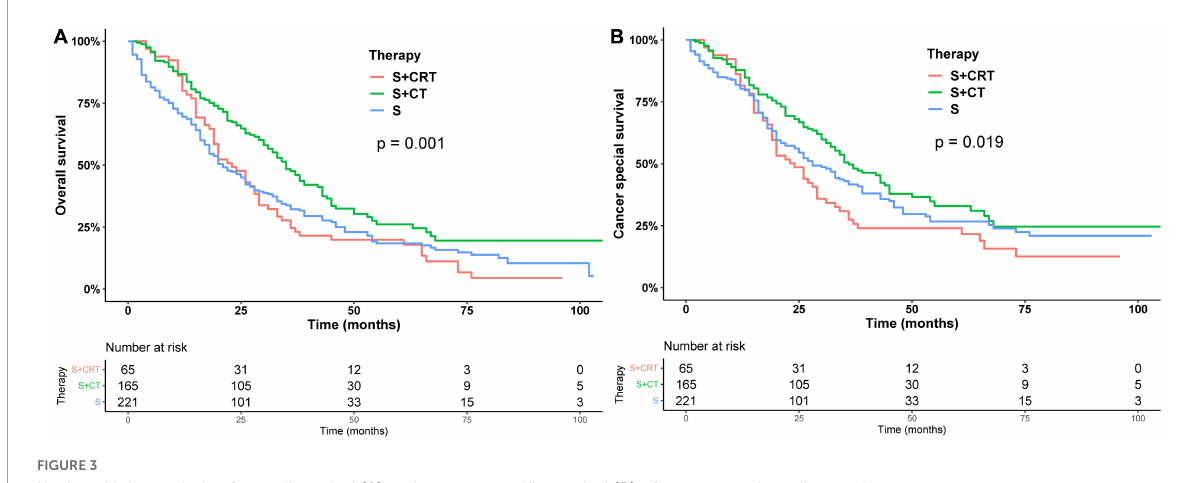
FIGURE3 Kaplan–Meier analysis of overall survival (A) and cancer-specific survival (B) of post-operative adjuvant therapy.